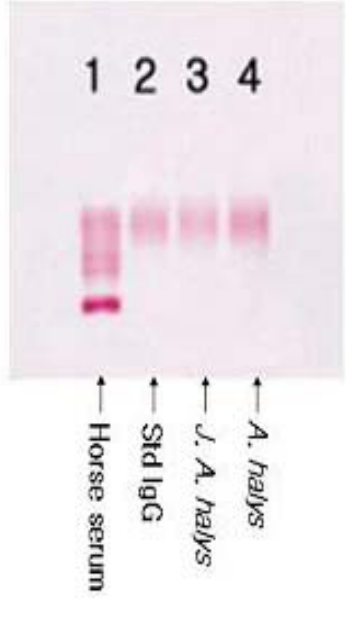
Figure 4: Median anti-lethal toxin effective dose (ED Jiangzhe Agkistrodon halys (China) antivenoms against 107.3 µg Jiangzhe